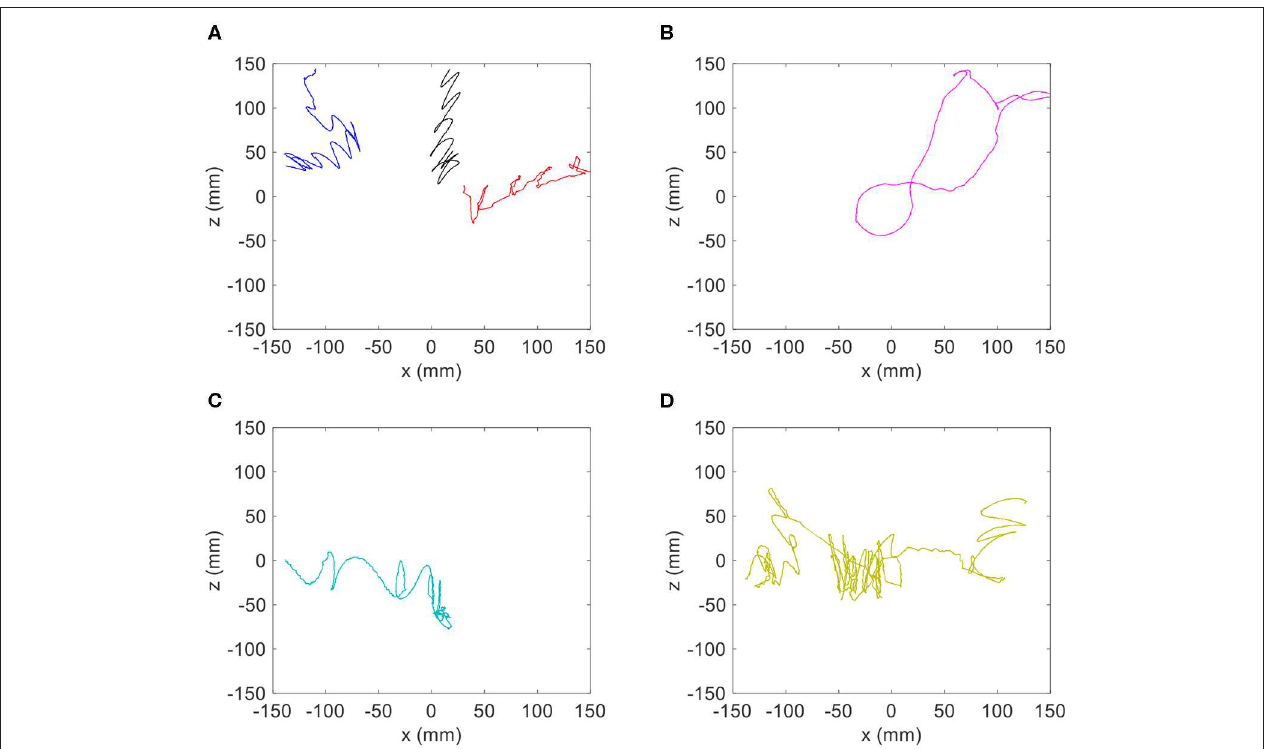
FIGURE 12 | Isolated copepod trajectories for the internal wave treatment with a density jump of 1.0 σ t to compare with the theoretical trajectories of passive particles. (A) Samples of trajectories that have a similar zig-zag motion to passive particles with superimposed horizontal velocity, and (B–D) samples of trajectories with loopy, orbital